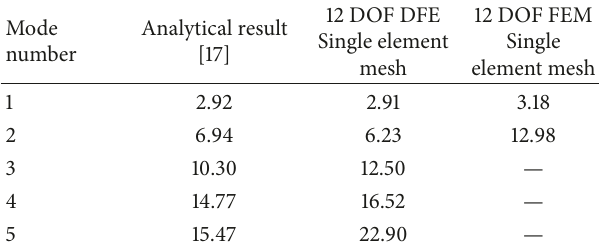
Table 1: Comparison of DFE and FEM formulations under SS-SS- SS-F boundary condition against analytical solution for values of 𝜔√𝜌𝑡/𝐷